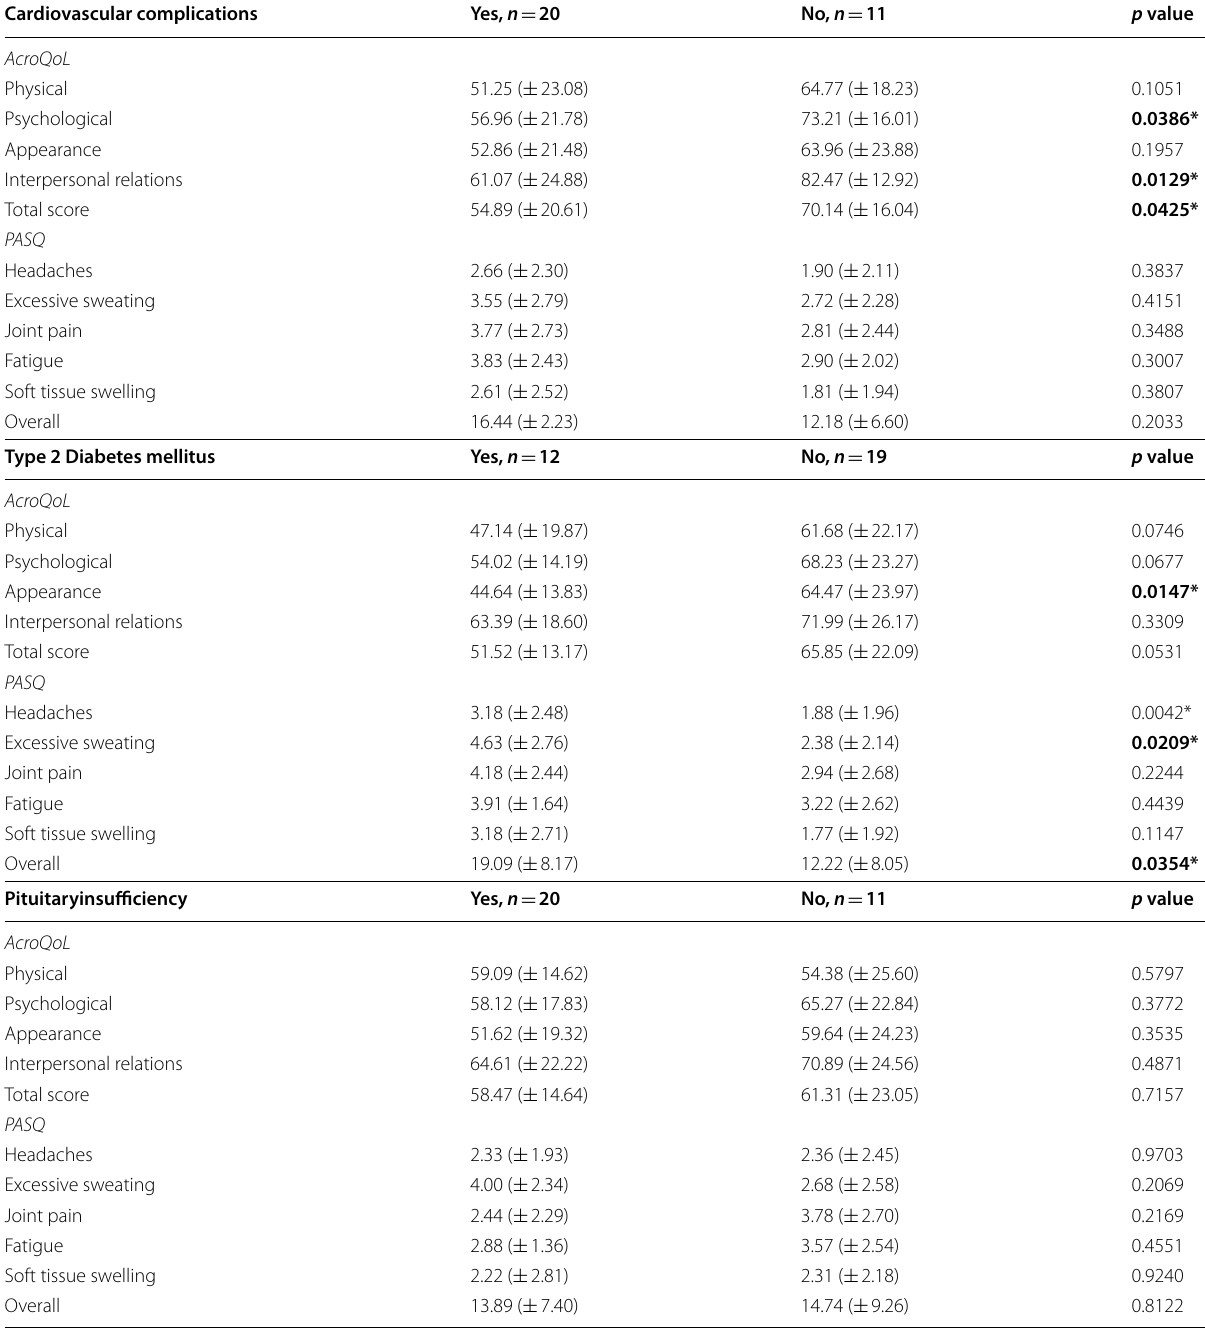
Table 5 AcroQoL and PASQ scores in relation to acromegaly